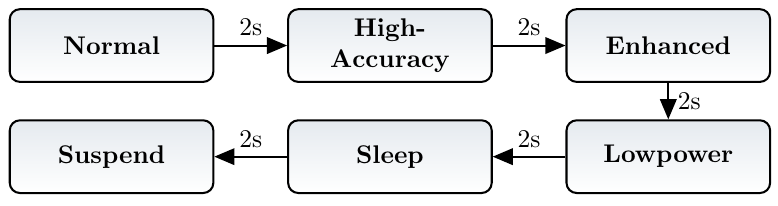
Figure 8. Control flow of magnetometer modes